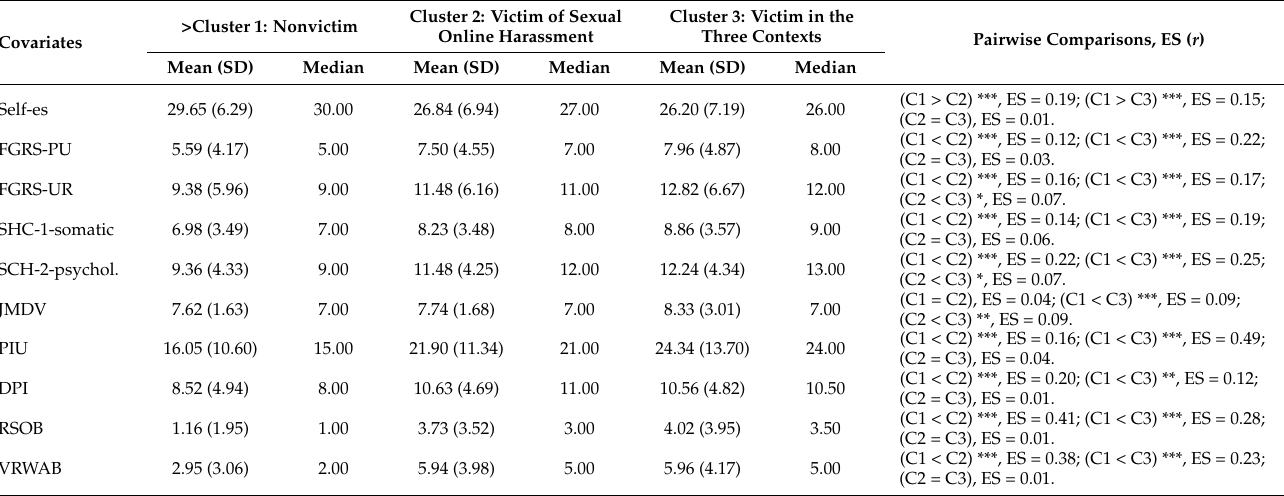
Table 4. Descriptive statistics of covariates in the three clusters, pairwise comparisons, and effect